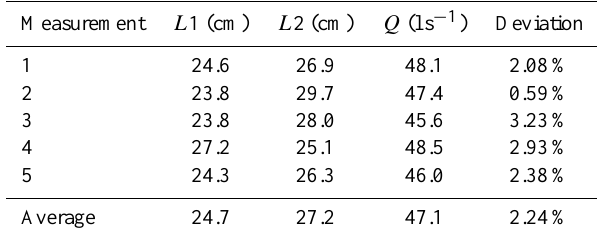
Fig. 7. The bubble envelope during low (3.3m 3 s − 1 ) and high (16m 3 s − 1 ) discharge, respectively. Table 1. Discharges measured with the photogrammetric technique in a laboratory flume with a constant discharge; the absolute devia- tions are relative to the average discharge measured with the ris- ing bubble technique; as a reference, hand measurements of the distances L 1 and L 2 (see Fig. 4) measured on average 25cm and 27cm,